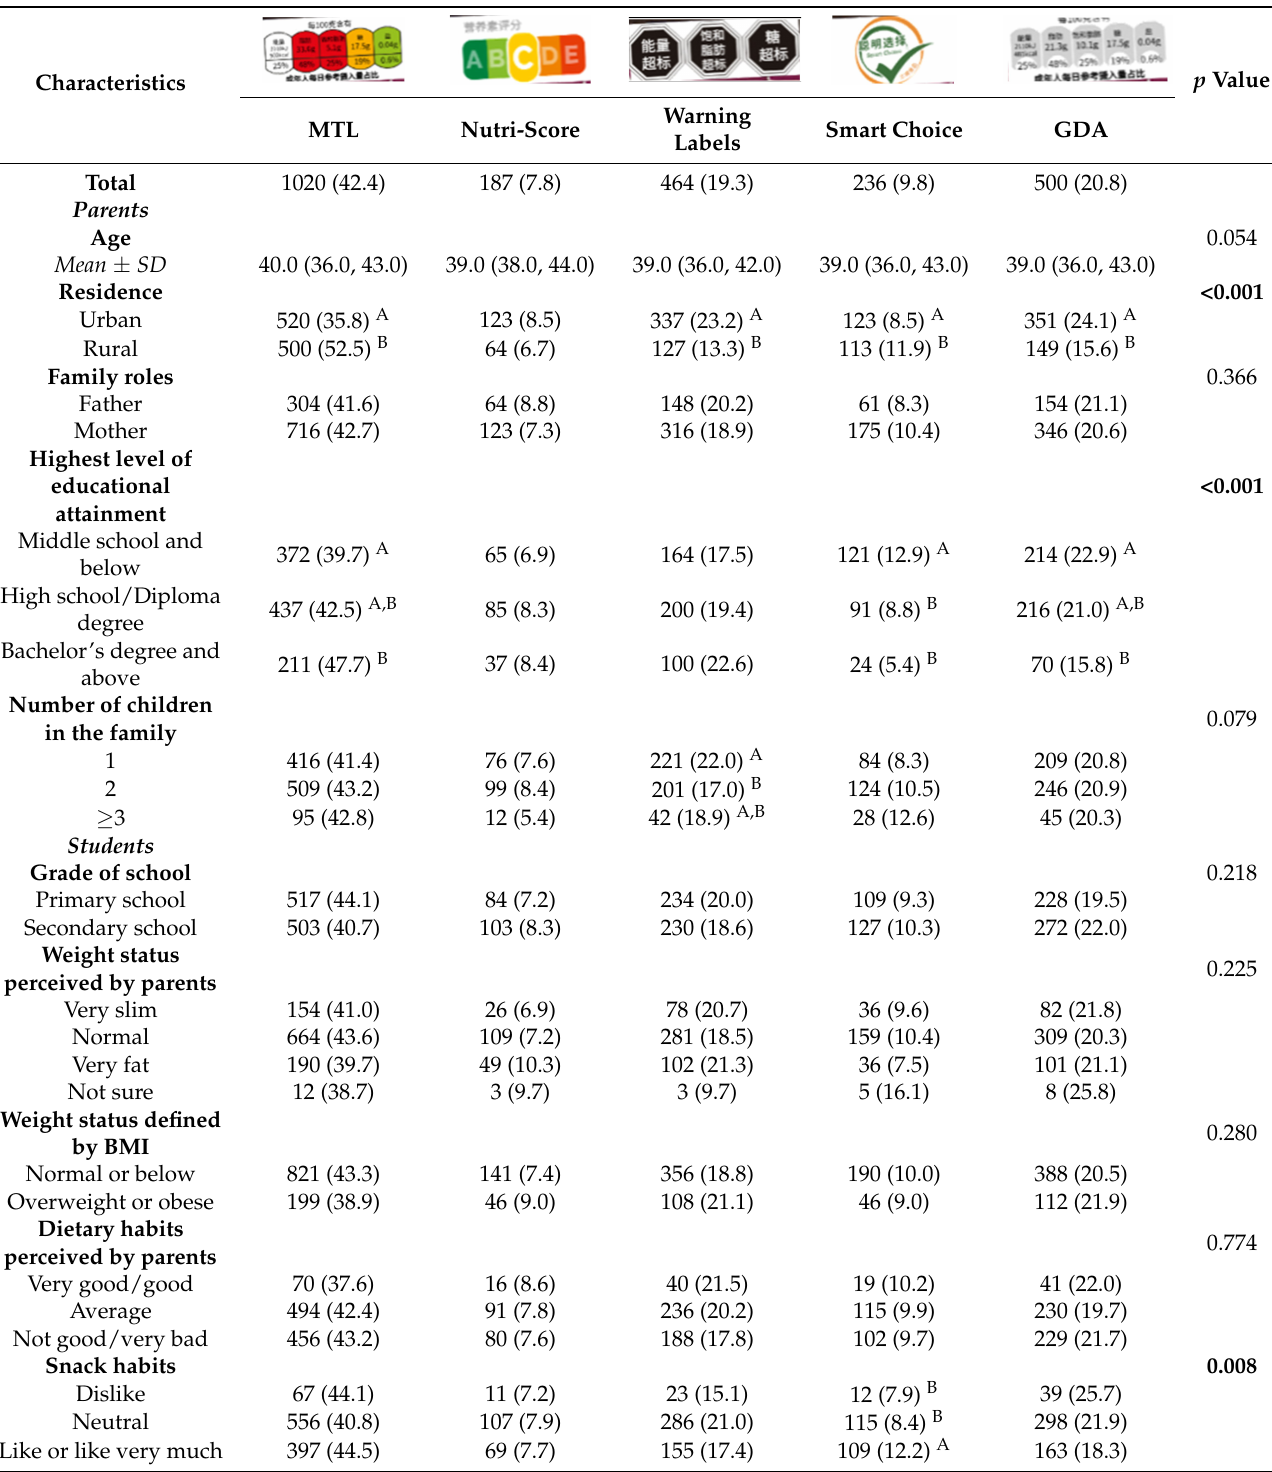
Table 3. FOPL format providing information Chinese parents needed most: n